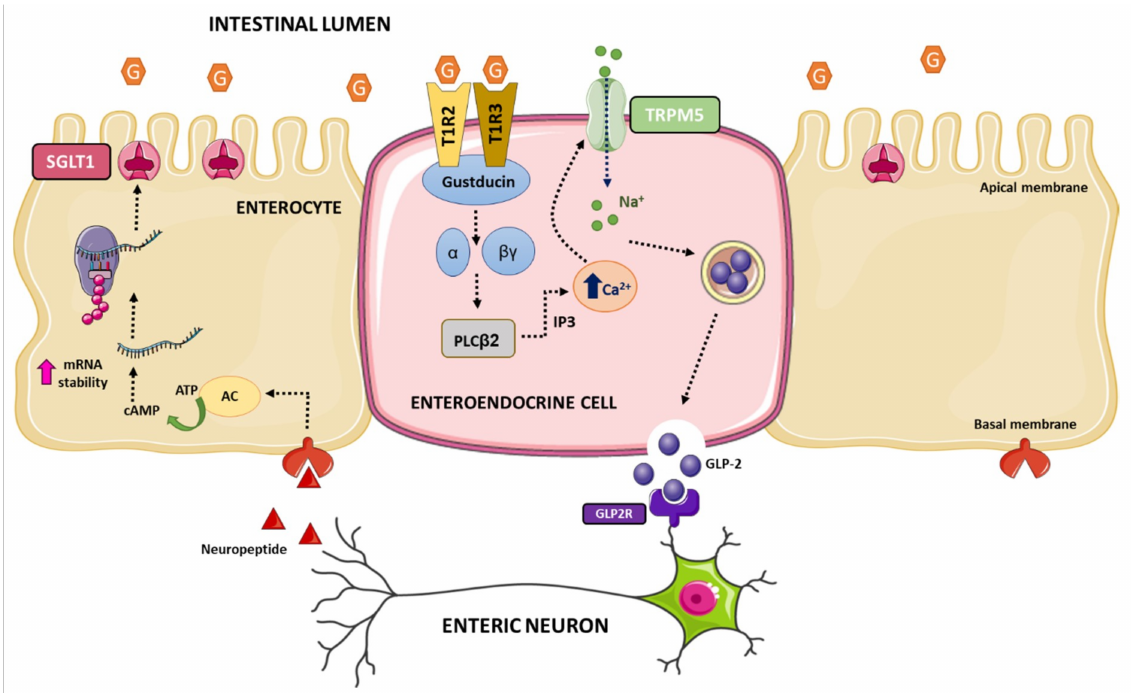
Figure 4. Model of intestinal glucose sensing and signaling pathways. Glucose (G) binds and activates the taste receptor type 1 member (STR) comprised of a heterodimer T1R2 + T1R3 and G-protein gustducin, leading to its dissociation into G α and G βγ subunits and activation of phospholipase C β β 2 (PLC 2 ) in enteroendocrine cells. Inositol 1,4,5-triphosphate (IP3) triggers intracellular calcium release resulting in increased sodium flux through type-5 transient receptor potential cation channel (TRPM5). Depolarization of the basal membrane results in GLP-2 release, which triggers release of an unidentified peptide from enteric neurons at neighbor enterocytes. Signal transduction in enterocyte leads to cAMP-mediated adenylate cyclase (AC) production that increases stabilization of Slc5a1 mRNA and ultimately augmented translation and insertion of SGLT1 into apical membrane. This figure was created using Servier Medical